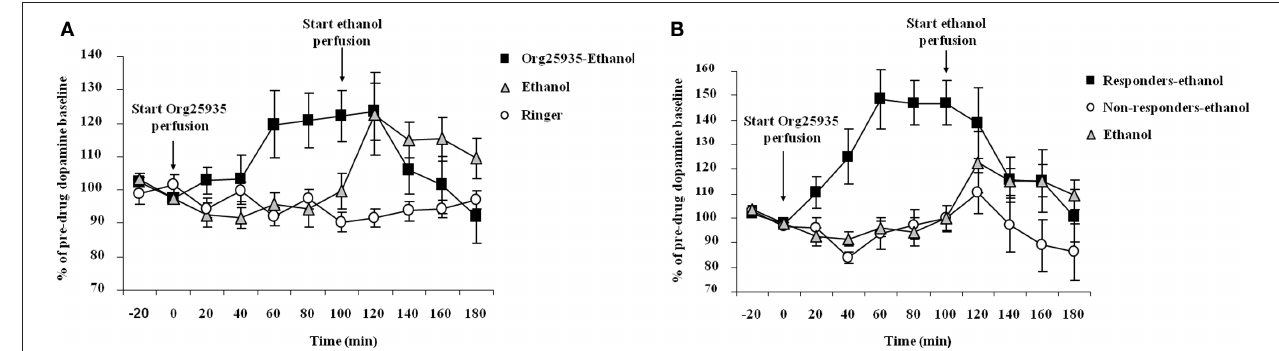
microdialysis after perfusion of 300 mM ethanol ( n = 7) and after Org25935 perfusion followed by ethanol co-perfusion in the responding ( n = 8) and non-responding ( n = 9) subgroup, shown as means ± SEM. Org25935 perfusion started at time point 0 min and ethanol perfusion started at time point 100 min, as indicated by arrows. Basal dopamine concentrations (mean ± SEM) for ethanol, drug responders and non-responders